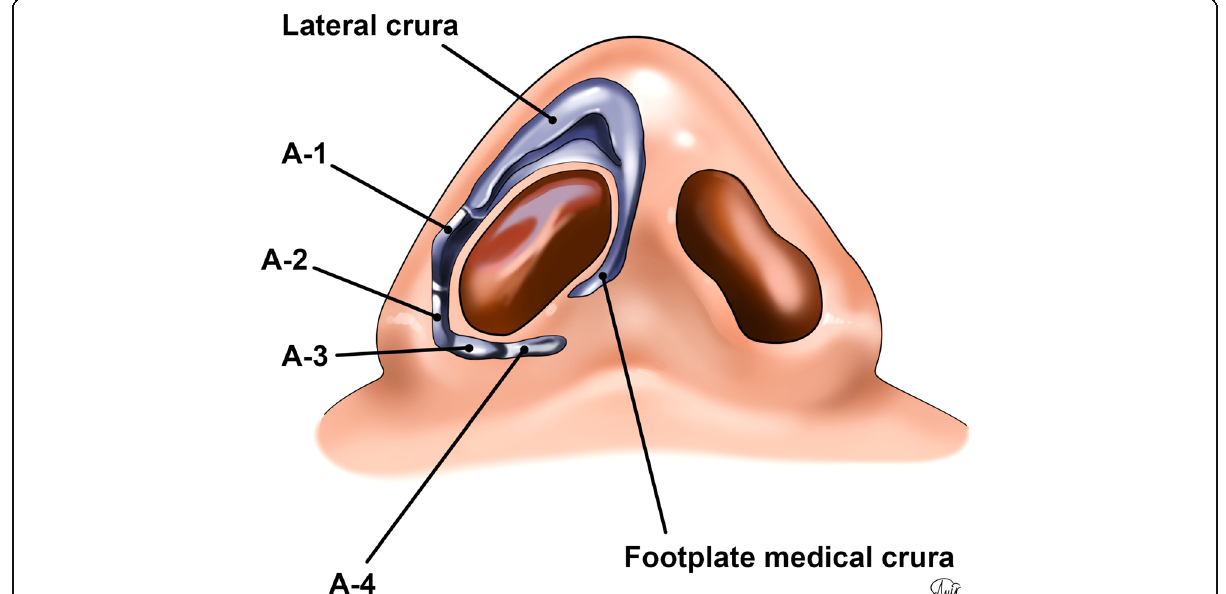
Fig. 8 The lateral and medial crura and alar ring and A1 to A4 cartilages, featuring basilar